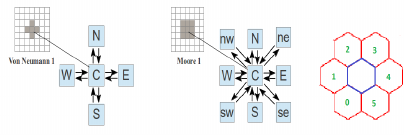
Figure 3. Neighborsof a